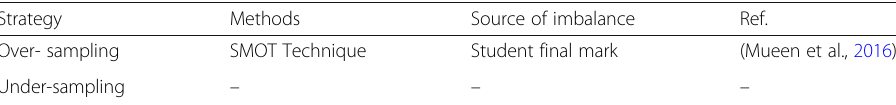
Table 12 Imbalanced datasets Strategy Methods Source of imbalance Over-